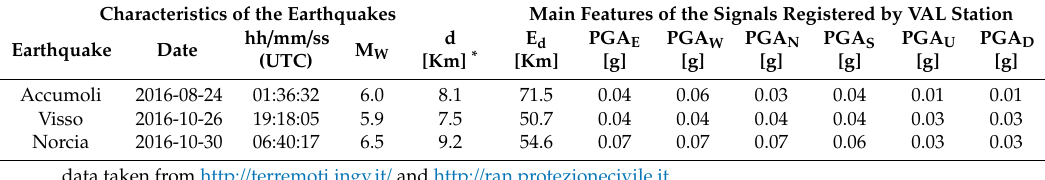
Table 1. Characteristics of the three considered mainshocks and main features of the seismic signal recorded at the “Valfabbrica” station